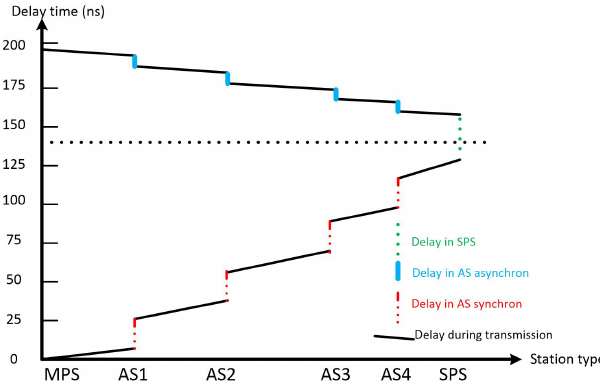
Figure 7. Schematic of the round-trip transmission delay in data frames between two power stations (MPS, master power station; AS, acquisition station; SPS, slave power station).